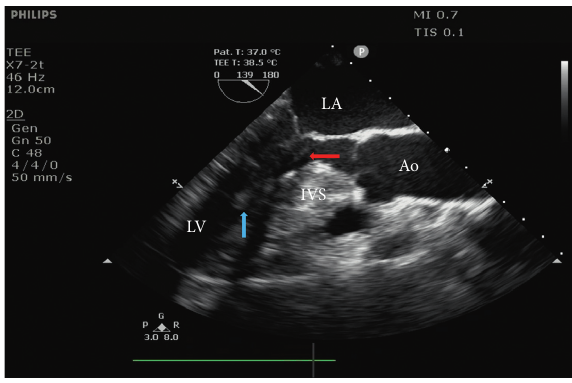
Figure 1: Mitral subvalvular